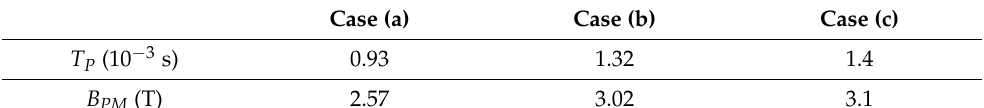
Figure 12. Different positions of the HTS bulk seeds (in black) in relation to the Hall probe (in blue). For case ( a ) the two seeds far from the Hall probe, case ( b ) one seed far from the Hall probe and one seed close to the Hall probe and case ( c ) the two seeds close to the Hall probe. Table 1 . Measurements of T P and B PM for the three cases (a), (b), and (c).